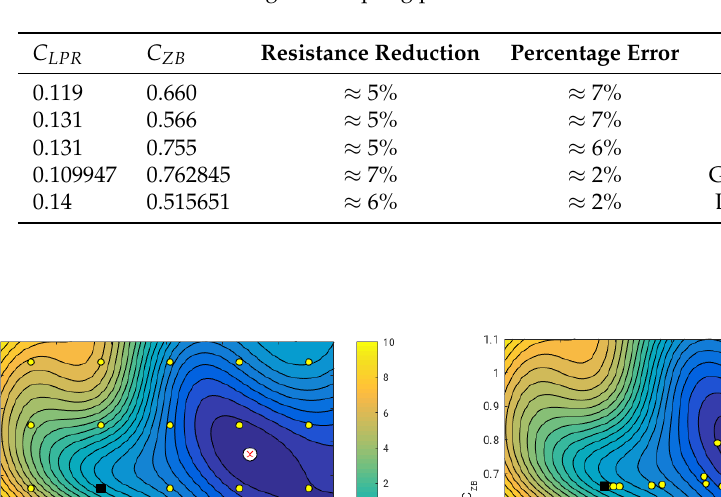
Table 5. Resistance reduction and percentage error (with respect to the high-fidelity simulations) of five cases not included in the original sampling plan.